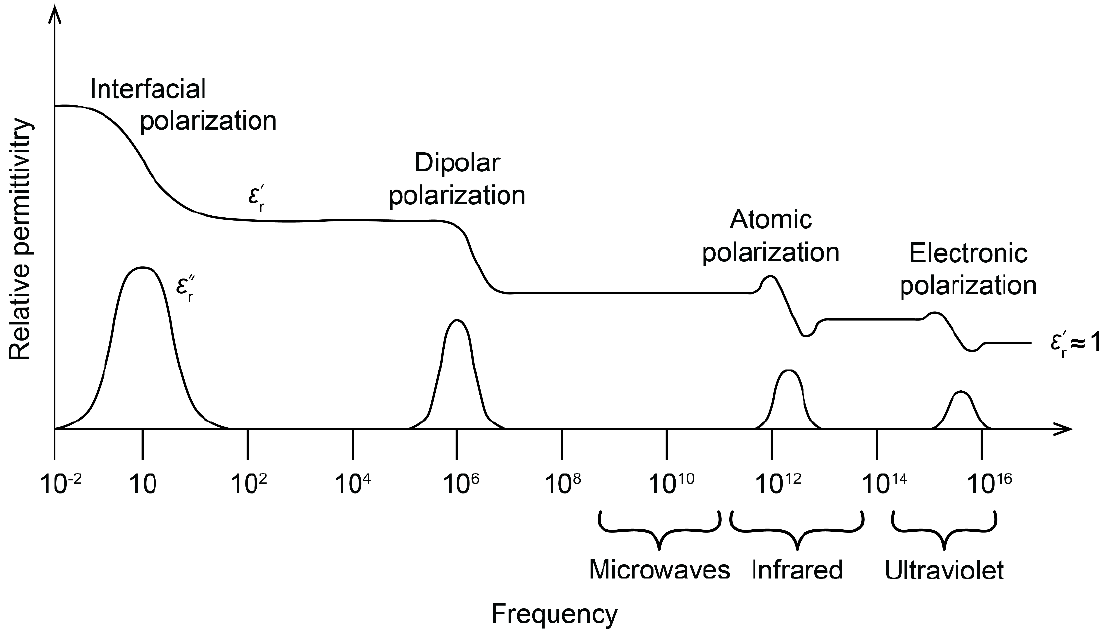
Figure 3. Frequency dependence of the complex relative permittivity: interfacial and dipolar polar- izations exhibiting relaxation processes whereas ionic and electronic polarizations exhibiting resonant processes. Redrawn from [45] (p. 608).